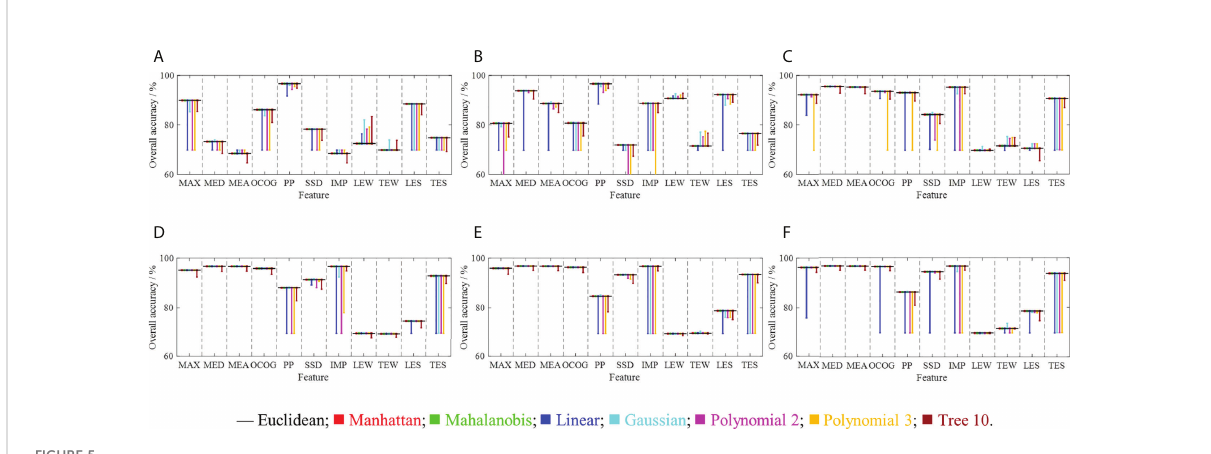
FIGURE 5 Overall accuracies of the individual RF, KNN and SVM models with different settings: (A) 0°; (B) 2°; (C) 4°; (D) 6°; (E) 8°; (F) 10°. The result of the Euclidean distance is expressed as the solid black line, and the other kernels, distances and Tree 10 are shown as bars based on the Euclidean distance. Upward bars express their accuracies higher than the overall accuracies of the Euclidean distance, and the downward bars express their accuracies less than the overall accuracies of the Euclidean